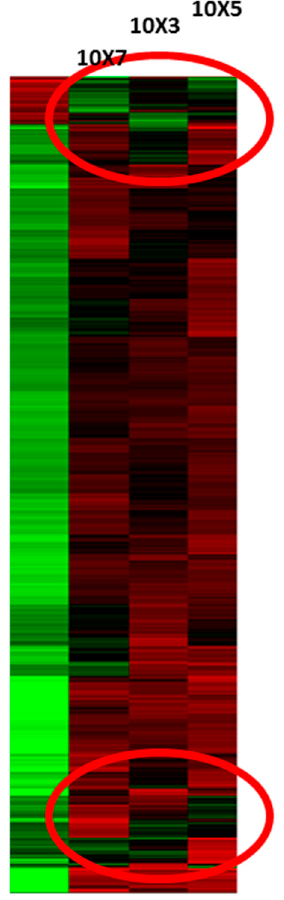
Figure 4. Hierarchical gene clusters (red circles) of expressed genes after treatment with different doses of WNV in cerebellar slice cultures. The left-most column represents mock treatment.